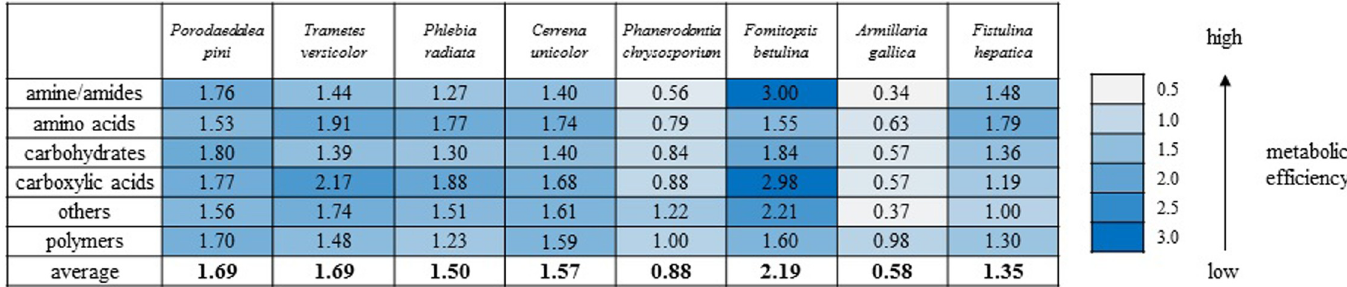
Fig 2. Ratio between normalized values of substrate use (OD 490nm) and biomass production (OD 750nm) defining theoretical metabolic efficiency of different wood-decaying fungi; P . pini FCL3, T . versicolor FCL7, P . radiata FCL99, C . unicolor FCL139, P . chrysosporium FCL 236, F . betulina FCL397, A . gallica FCL400, F . hepatica